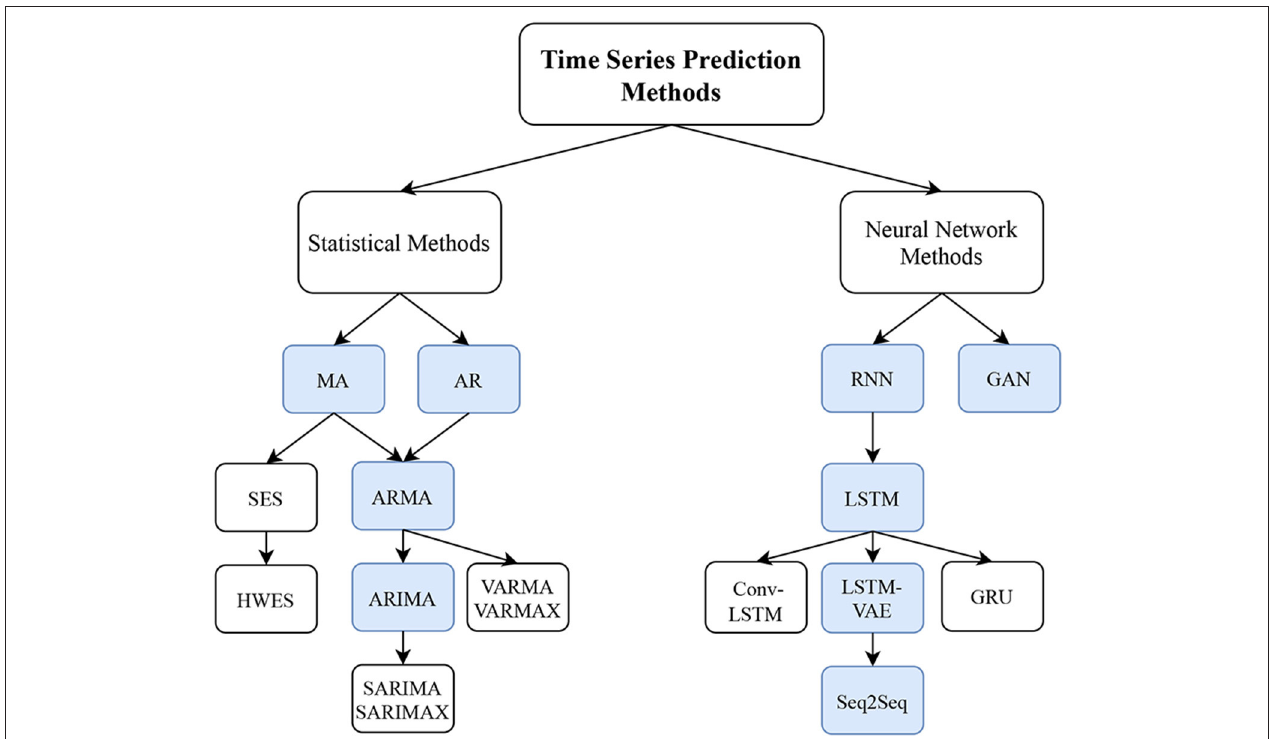
FIGURE 2 | Hierarchical structure of time series prediction techniques in both statistical and machine learning approaches. For statistical methods, our main focus is on the blue boxes (i.e., AR , MA , ARMA , and ARIMA ) as they are the more fundamental methods. The remaining methods are their extensions. For Neural Network Methods, we focus on the RNN , LSTM , Seq2Seq , and GAN methods, which are in blue